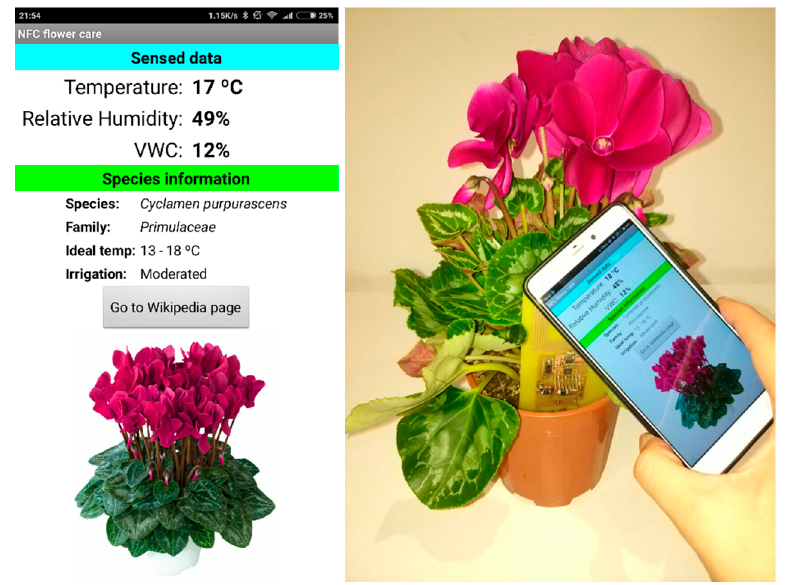
Figure 13. Soil moisture NFC tag being powered and read by a smartphone, which retrieves the sensed data and the tag unique identifier (UID) to identify the species [71].